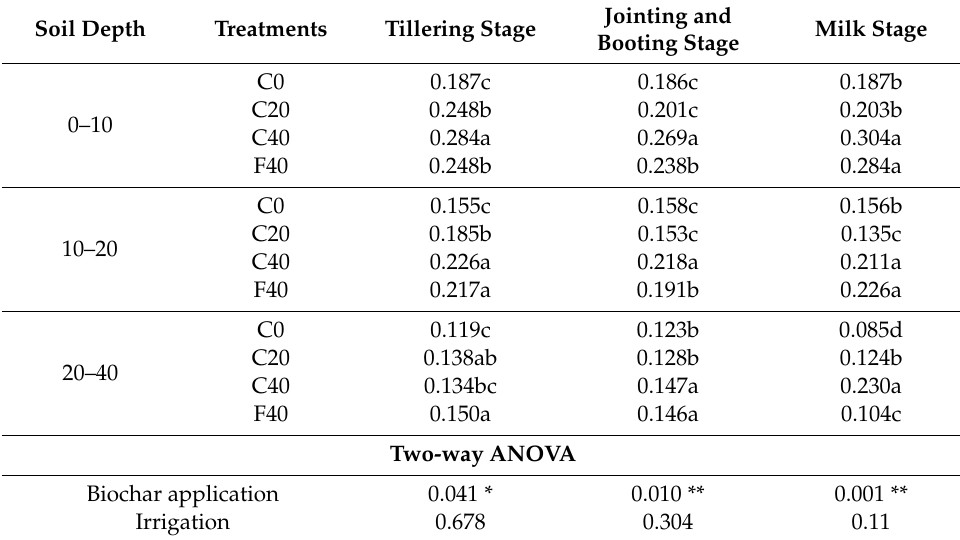
Table 5. Characteristics of soil invertase (INV) activity under di ff erent water-carbon regulation scenarios in paddy fields (mg /